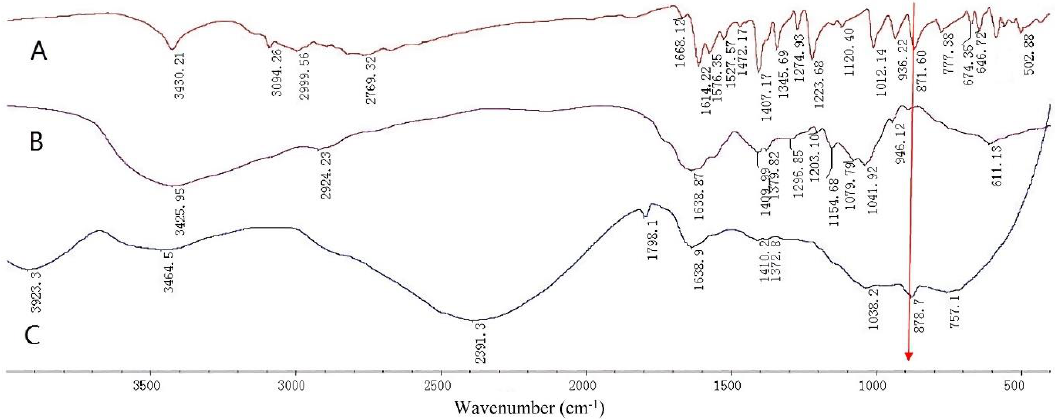
Figure 5. Fourier transform infrared (FT-IR) spectra of ( A ) 6-mercaptopurine (6-MP), ( B ) HA-DOP, and ( C ) HA-DOP-Cu-MP.